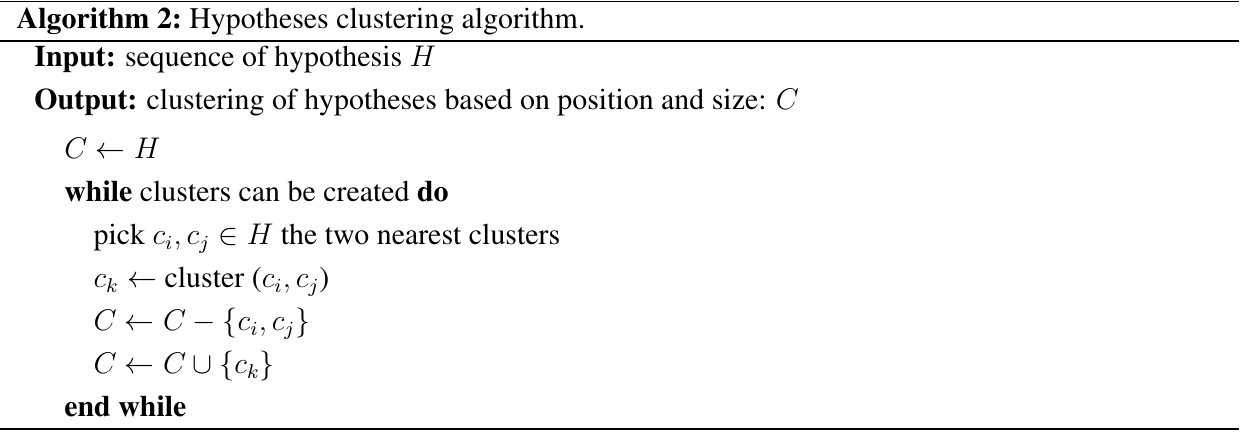
Algorithm 2: Hypotheses clustering